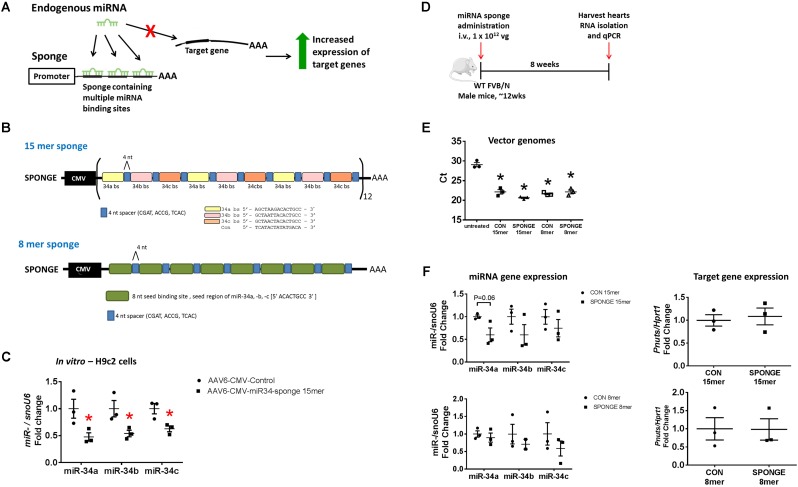
Design and testing of a miR-34 sponge. (A) A construct containing multiple miRNA binding sites act as a competitive inhibitor and “soaks up” endogenous miRNA preventing binding to target genes, resulting in increased expression of target genes. (B) A schematic showing the design of the miR-34a 15mer and 8mer sponge. The 15mer sponge contains four tandem repeats of the binding sites for miR-34a (yellow), miR-34b (pink), and miR-34c (orange), four nucleotide spacers (blue), under the control of the CMV promoter. The 8mer sponge contains eight tandem repeats of the miR-34 seed region (green), four nucleotide spacers (blue), under the control of the CMV promoter. (C) miR-34a, -b, and -c gene expression in H9c2 cells transfected with AAV6-CMV control or AAV6-CMV-miR-34 15mer sponge. Data shown as mean ± SEM. Un-paired t-test. ∗P < 0.05. N = 3/group. (D) Experimental timeline. (E) Detection of vector genomes in untreated, AAV6:CON and AAV6:sponge (15mer and 8mer) treated hearts. Lower Ct (cycle threshold) indicates higher expression. N = 3/group. Data mean ± SEM. One way ANOVA with Fisher’s post hoc test. ∗P < 0.05 vs. untreated. (F) Expression of miR-34a, miR-34b, and miR-34c (left) and Pnuts (right) by qPCR in control and miR-34 sponge 15mer and 8mer treated hearts. Data mean ± SEM. N = 3/group (except N = 2 for miR-34b in 8mer sponge). Abbreviations: AAA, poly A tail; bs, binding site; i.v., intravenous; vg, vector genomes.